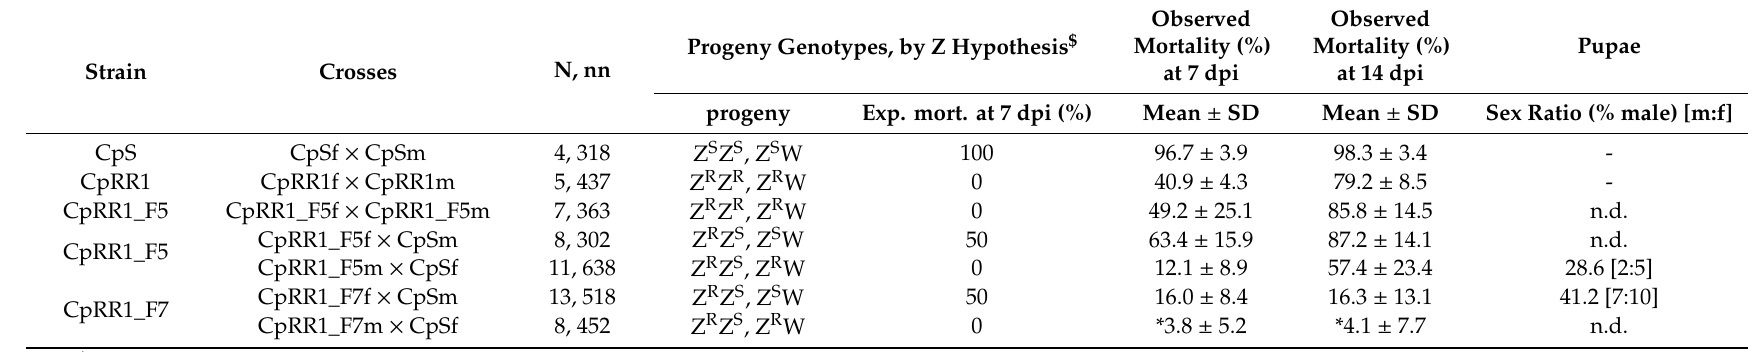
Table 3. Resistance testing of neonate larvae from single-pair crossings of CpRR1_F5 or CpRR1_F7 with CpS exposed to CpGV-M at a discriminating concentration of 5.8 × 10 4 OBs / mL. Given are the crosses and the number of independent single-pair crossings (N), total number of tested larvae (n), Progeny genotypes by the hypothesis of Z-chromosomal inheritance, mean mortality and standard deviation (SD) after 7 and 14 days post infection (dpi), as well as the sex ratio of pupae; f, female; m,